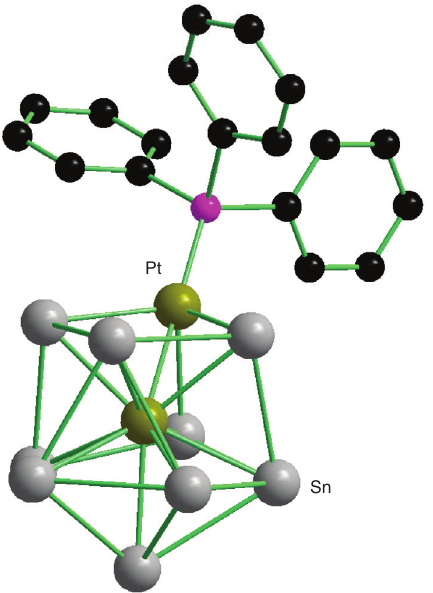
Figure 7 Simplified view of the molecular structure (diamond) of [(PPh )Pt Sn ] 2- (Kesanli et al., 2002). 3 2 9